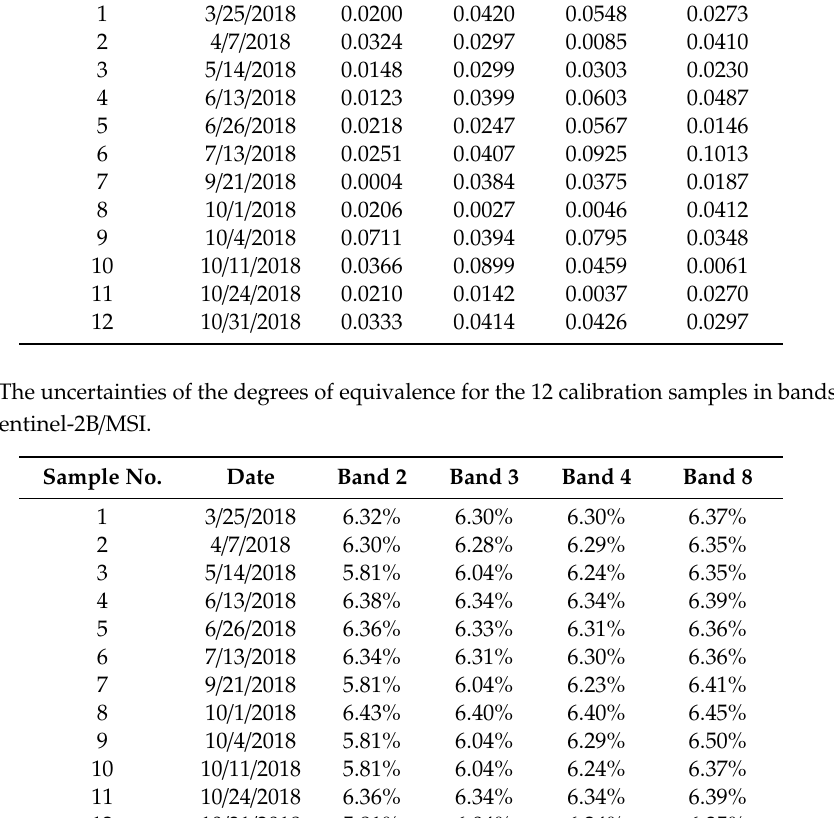
Table 11. The degrees of equivalence for 12 calibration samples in bands 2, 3, 4, and 8 of Sentinel-2B / MSI. Sample No.